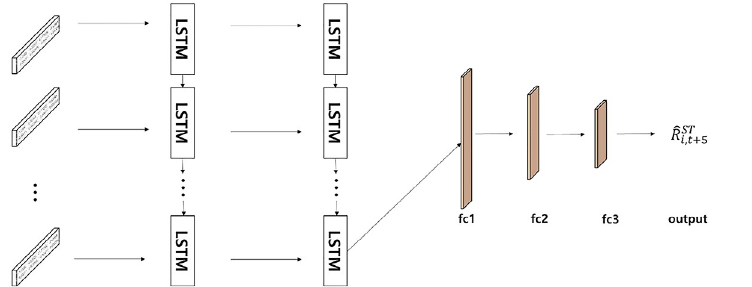
Fig 10. The architecture of the ST-LSTM